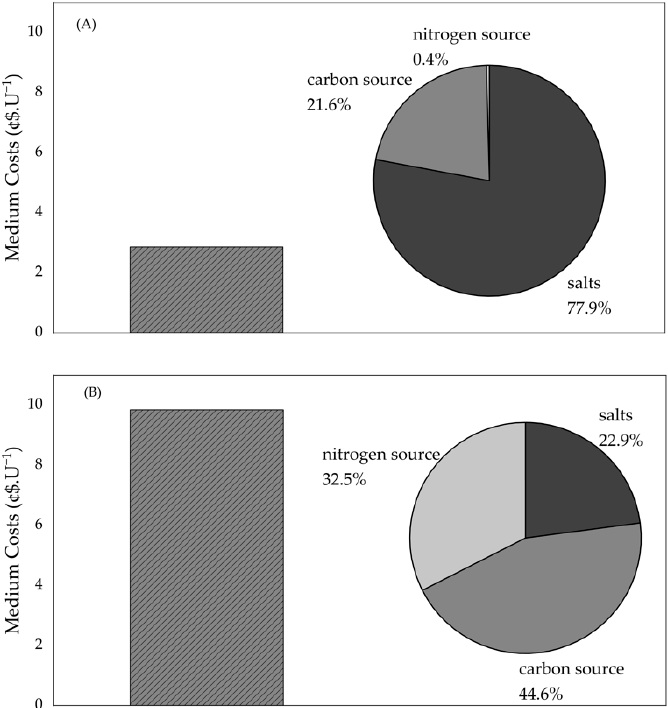
Figure 9. Medium costs and cost distribution among the different components of the culture medium: ( A ) standard medium (Exp. 1) and ( B ) optimized medium (Exp. 13).